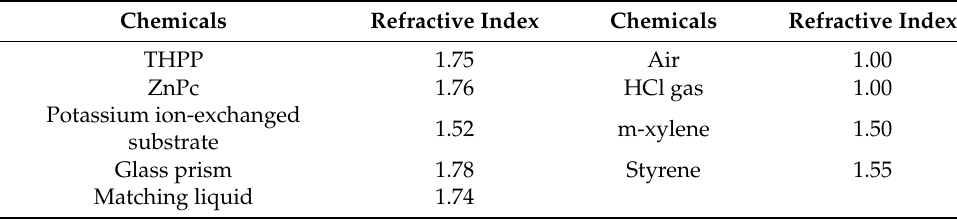
Table 1. Refractive indexes (589.3 nm) of related analyte chemicals (101,325 Pa, 298 K).